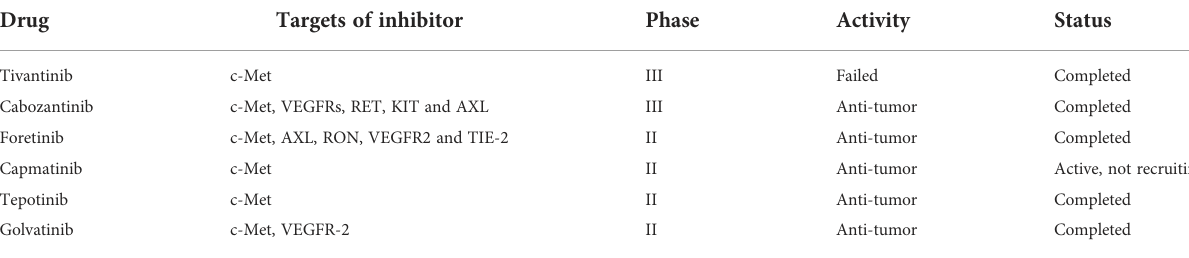
Drug Targets of inhibitor